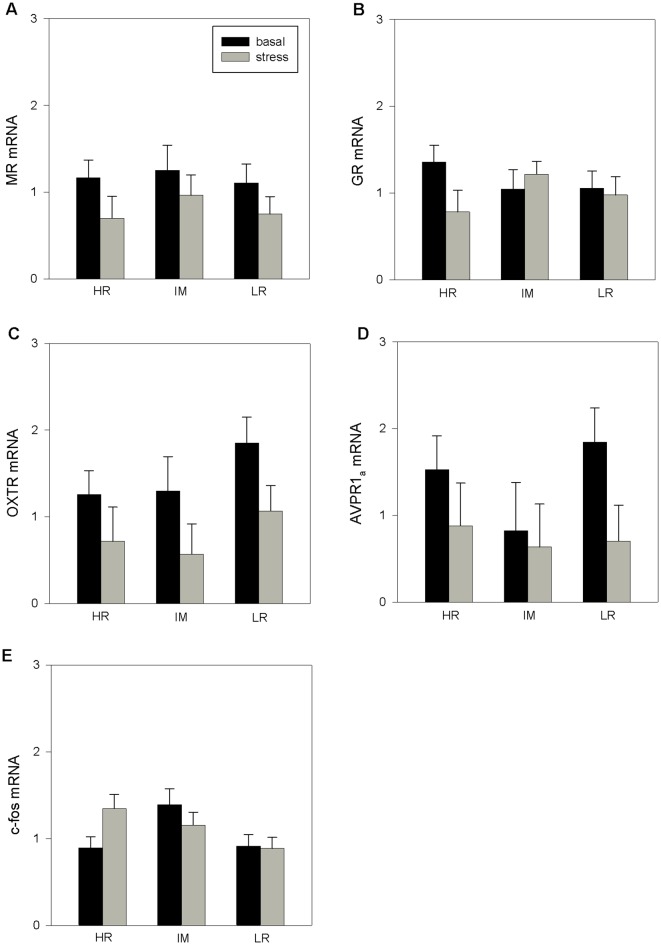
The basal and stress-induced mRNA expression of mineralocorticoid receptor (MR; A), glucocorticoid receptor (GR; B), oxytocin receptor (OXTR; C), arginine vasopressin receptor 1a (AVPR1a; D) and c-fos (E) in the prefrontal cortex (PFC) of piglets with high-resisting (HR), intermediate (IM) and low-resisting (LR) backtest classifications. Data are expressed as arbitrary units after normalization to ACTB and TBP mRNA expression as endogenous reference genes and represent the least square means (LS means) ± standard errors (SE).